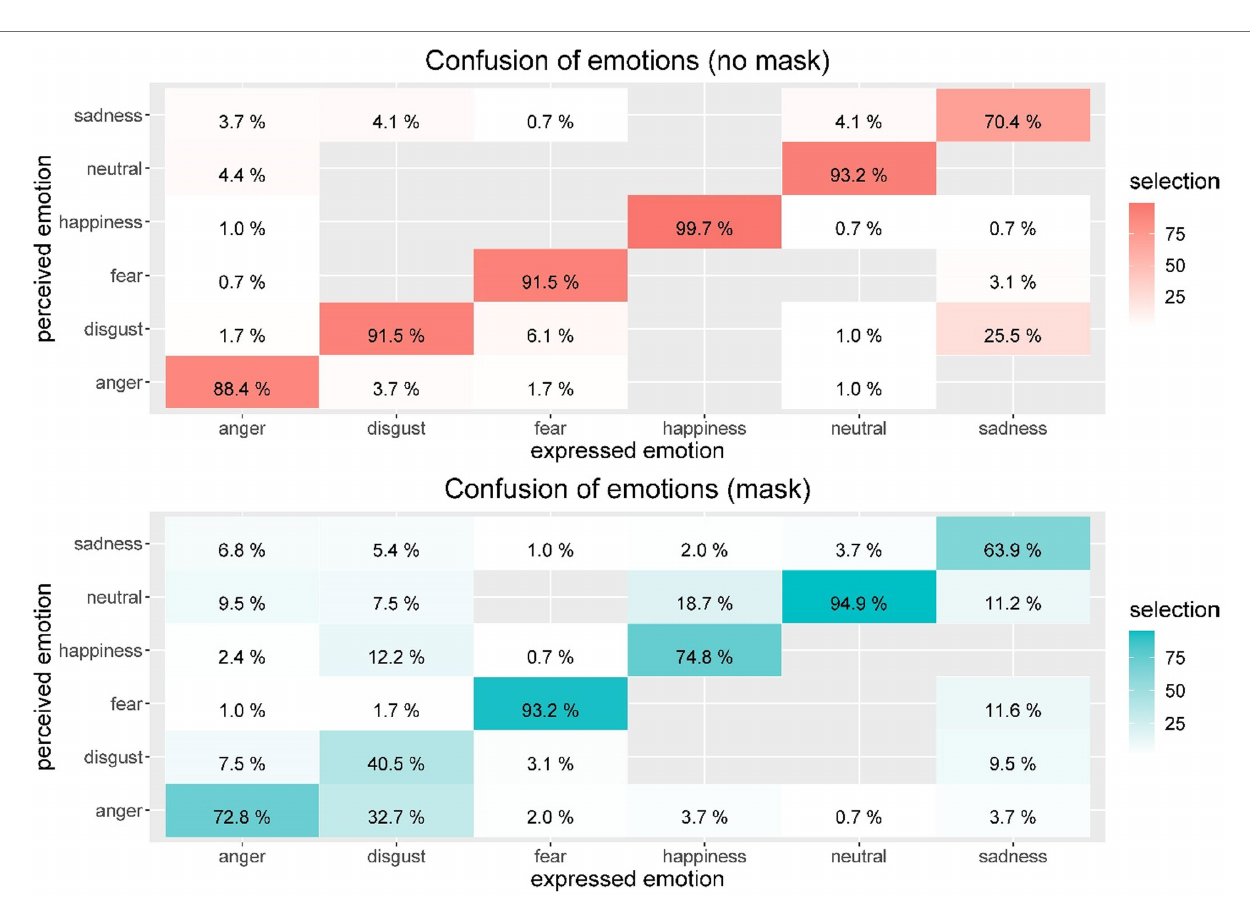
FIGURE 3 | This figure shows the confusion matrices for expressed versus perceived emotions for the original faces without face masks (top red) and faces with face masks (bottom blue). Mean performance levels in assessing the emotional states are given by percentage correctness rates (if >0.5%, otherwise data were suppressed for better readability of the matrices). The better the performance, the more saturated were the confusion matrix